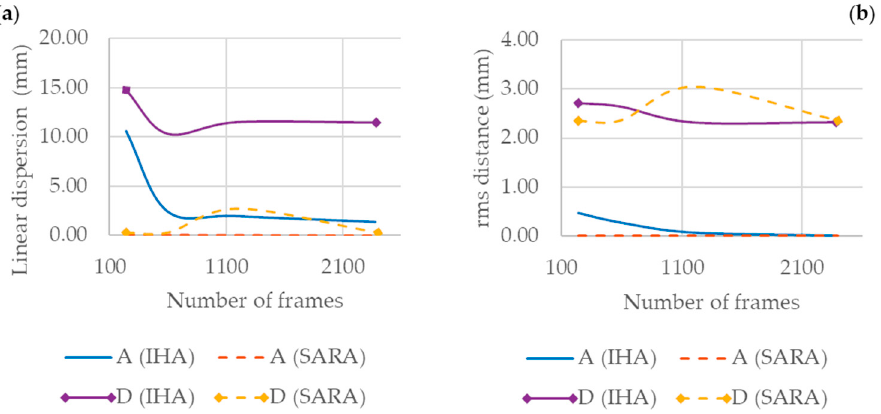
Figure 12. Linear dispersion ( a ) and rms distance ( b ) in A and D motion configurations, for different sampling rate. Results are shown for IHA (w.1) and SARA algorithms.